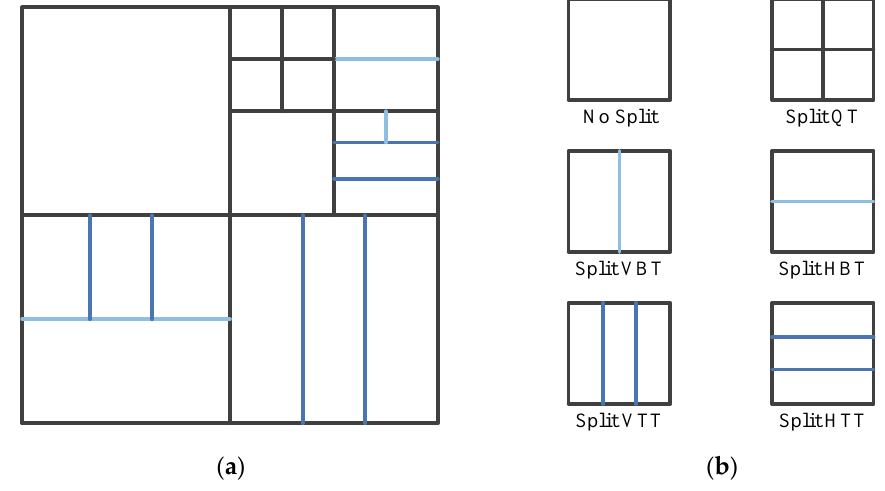
Figure 1. CU partitioning in VVC: ( a ) 64 × 64 CU as an example; ( b ) VVC split types. In detail, in HEVC, a coding tree unit (CTU) is split into many sub-CUs by the QT structure, and each sub-CU can be further split into one, two, or four prediction units (PUs) depending on the PU’s division type. After the PU is predicted and residual information is obtained, the sub-CU can be further split into several transform units (TU), and the division method is still QT division. In VVC, the PU and TU are canceled, and the concept of CU is used uniformly. Multiple division types can be used to divide CUs to obtain CUs of different sizes, which is also the biggest difference between VVC and HEVC in block division technology [7].